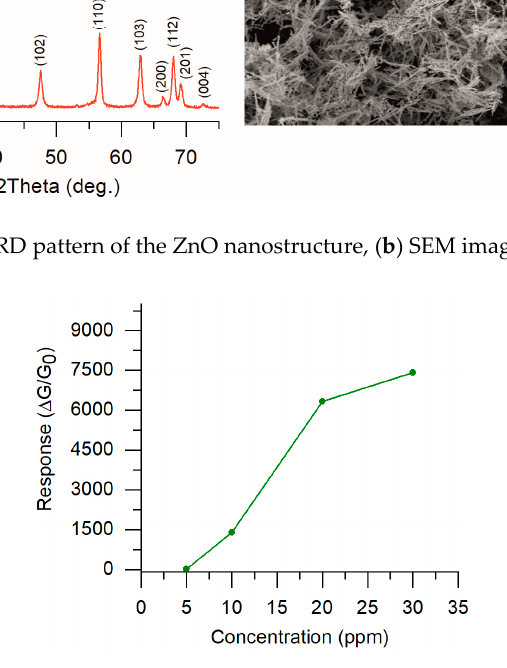
Figure 2. Gas sensing response variation of the ZnO depending on the concentration of H 2 S (5, 10, 20 and 30 ppm) at 400 °C.